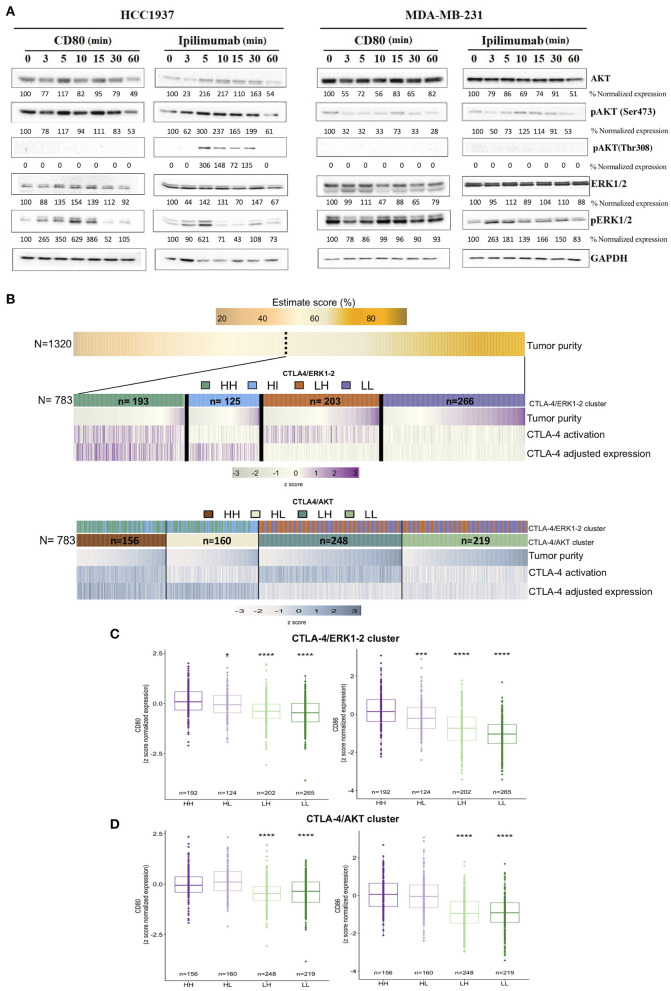
Transcriptional landscape of activated-like CTLA-4 in human tumors from publicly available data. (A) Evaluation of AKT and ERK1/2 activation signaling pathways after incubation with either CD80 (0.15 μg/ml) or Ipilimumab (10 μg/ml) at the indicated time points. Activation of AKT was evaluated by Western blot using antibodies against phosphorylated Ser473 (pAKT-Ser473) and Thr308 (pAKT-Thr308) residues. Activation of ERK1/2 was analyzed by using an antibody that recognizes phosphorylated Thr185 + Thr202 + Tyr204 + Tyr187 residues (pERK1/2). Expression of GAPDH was included as loading control. Densitometric analysis indicated as percentage below each blot, taking time 0 as reference for each evaluated protein. (B) Heatmap of decoding tumor subgroups based on CTLA-4 expression and activation. First panel shows the inferred tumor purity value (%) among the complete TNBC cohort (N = 1,320). The following panels display selected tumors based on tumor purity above 60% (N = 783). Middle panel shows tumor subtype features of CTLA-4 ERK1-2 tumors, while lower panel shows features of CTLA-4 AKT tumors. Samples represented in the plot were sorted by tumor purity value in each cluster. CTLA-4 expression value was adjusted by CD8/CD4/lymphocyte infiltration and ESTIMATE value. Boxplots of CD80 and CD86 normalized expression values in (C) CTLA-4/ERK cluster and (D) CTLA-4/AKT cluster (HH: CTLA-4H/H−ERK1/2 and CTLA-4H/H−AKT; HL: CTLA-4H/L−ERK1/2 and CTLA-4H/L−AKT; LH: CTLA-4L/H−ERK1/2 and CTLA-4L/H−AKT; LL: CTLA-4L/L−ERK1/2 and CTLA-4L/L−AKT). (*p-value ≤ 0.05; ***p-value ≤ 0.001; ****p-value ≤ 0.0001).